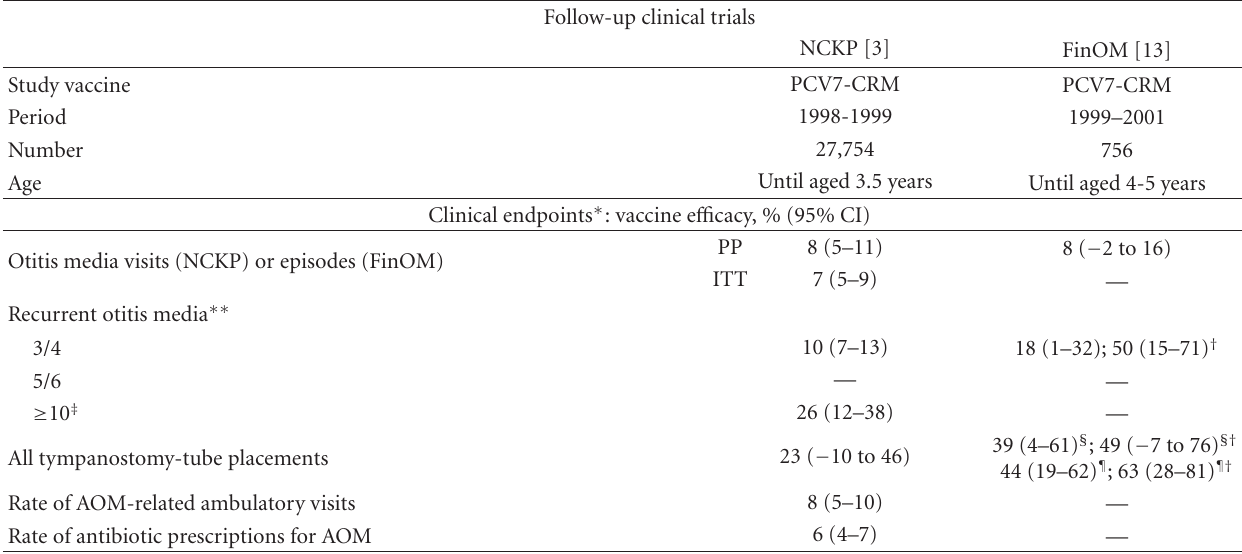
Table 4: Vaccine e ffi cacy values in the long-term followup of PCV clinical trials with otitis media as an endpoint [3,13]. Adapted with permission from Fletcher and Fritzell, 2007 Elsevier Ltd. All rights reserved